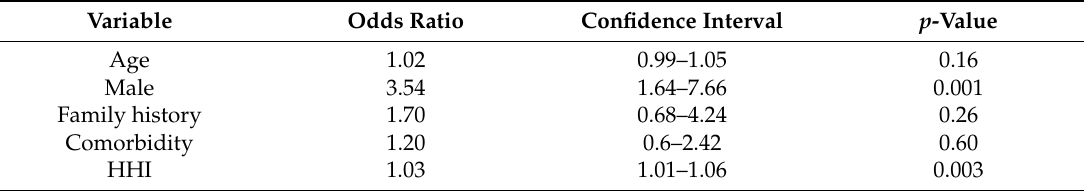
Table 5. Binary logistic regression analysis for variables such as age and sex, comorbidities, family history for hearing loss and HHI questionnaire score in patients with a higher degree of hearing loss. Statistically-significant results are shown in bold.